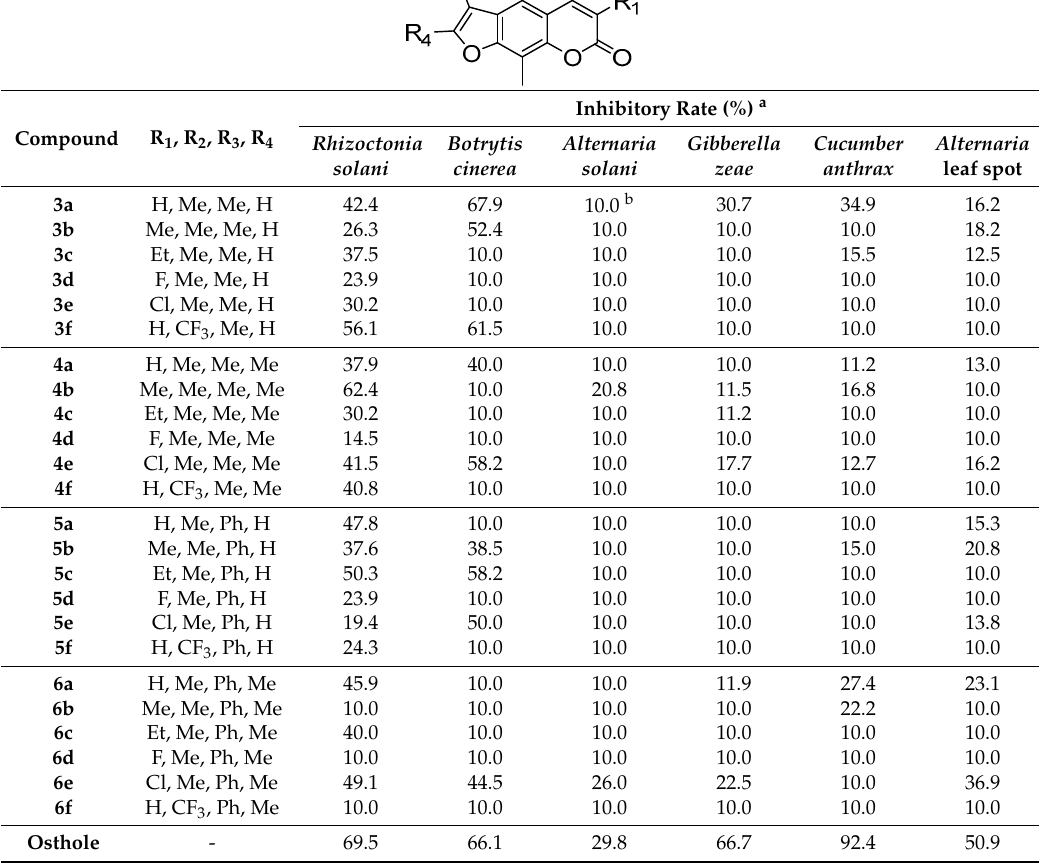
Table 1. Preliminary antifungal activities of all target compounds.